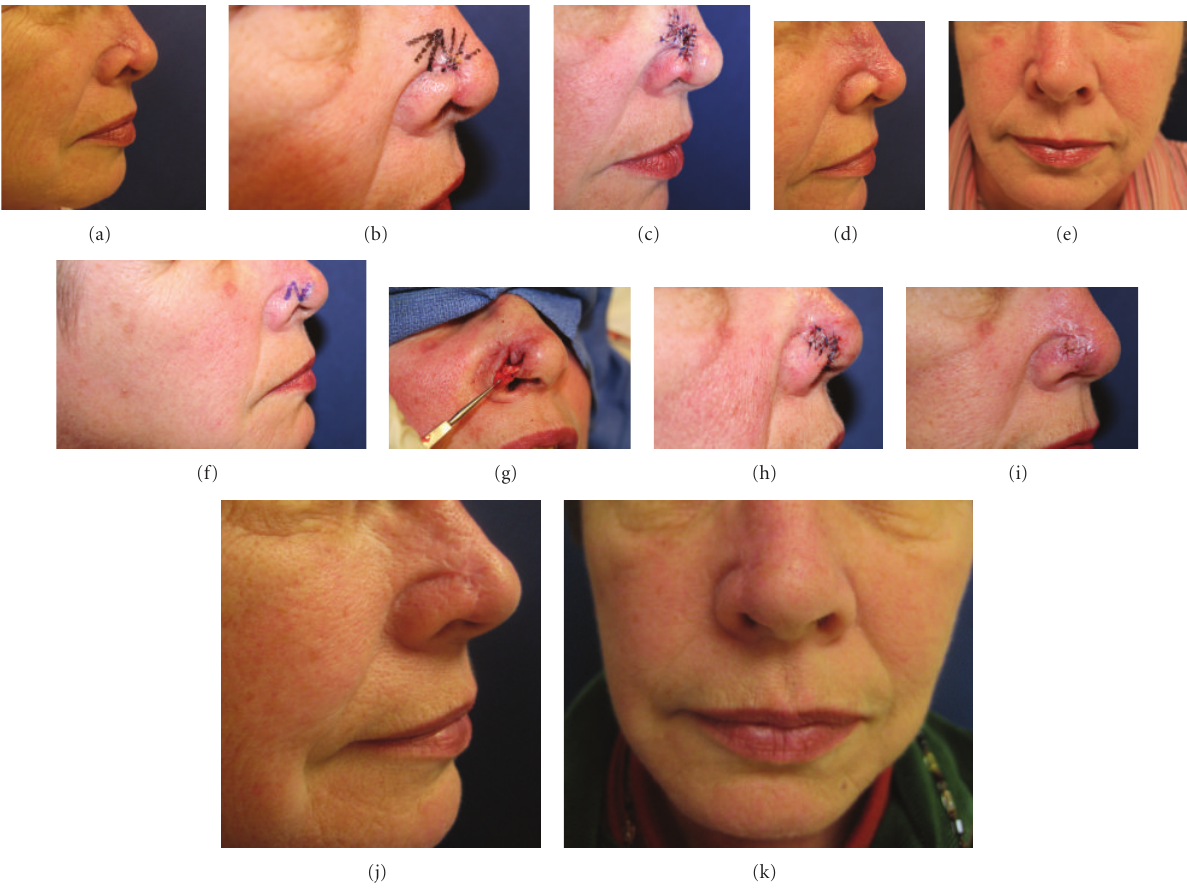
Figure 5: (a) Alar retraction secondary to multiple tumor extirpations resulting in an ecnasion. (b) A Z-plasty is planned. One relatively simple way to estimate the angles is to draw out the peripheral arms at 90 angles to the central limb and then divide this in 1/2 to get 45- degree angles or trisect it to obtain 30- or 60-degree angles as shown. (c) Z-plasty sutured in place. ((d) and (e)) Frontal and lateral views demonstrating that alar retraction has improved but not completely resolved (cf. Figure 5(a)). (f) Another, more inferior Z-plasty is planned